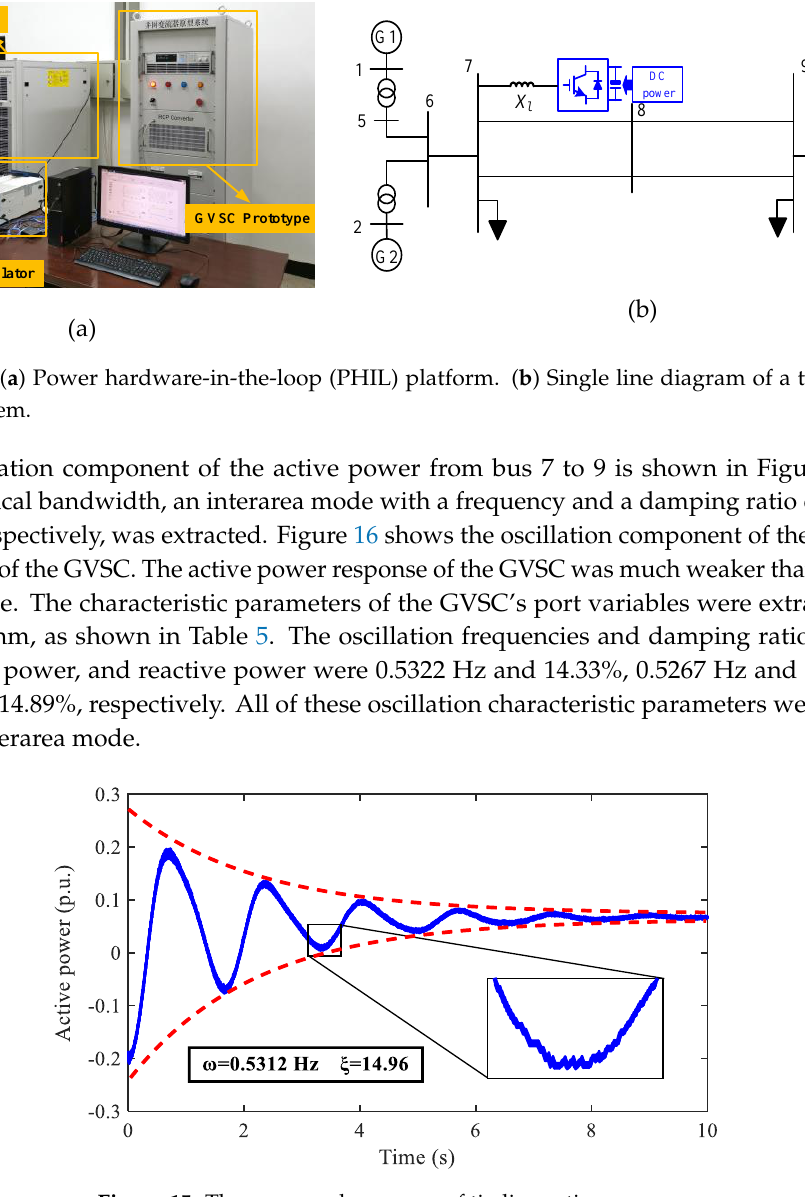
Figure 15. The measured response of tie-line active power.